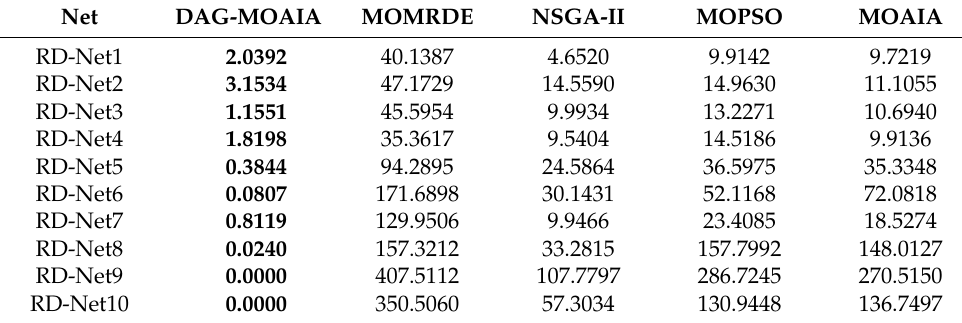
Table 5. Mean values of IDG (best results are shown in